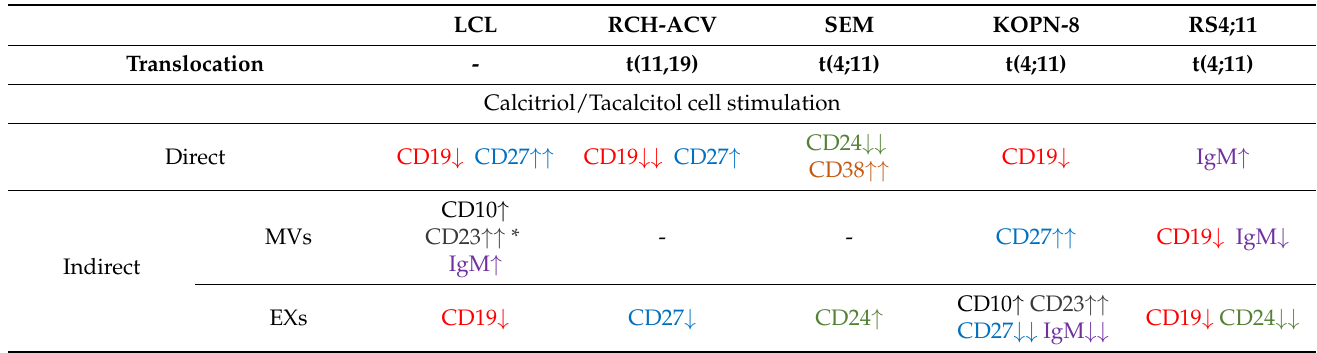
Table 2. The direct/indirect impacts of calcitriol/tacalcitol on normal and leukemic B cells.